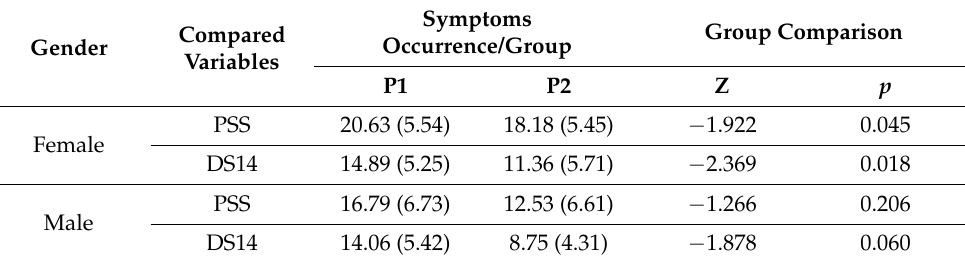
Table 4. Comparison of the mean results of the measurement of stress and type D personality among people suffering from one SS symptom, taking into account